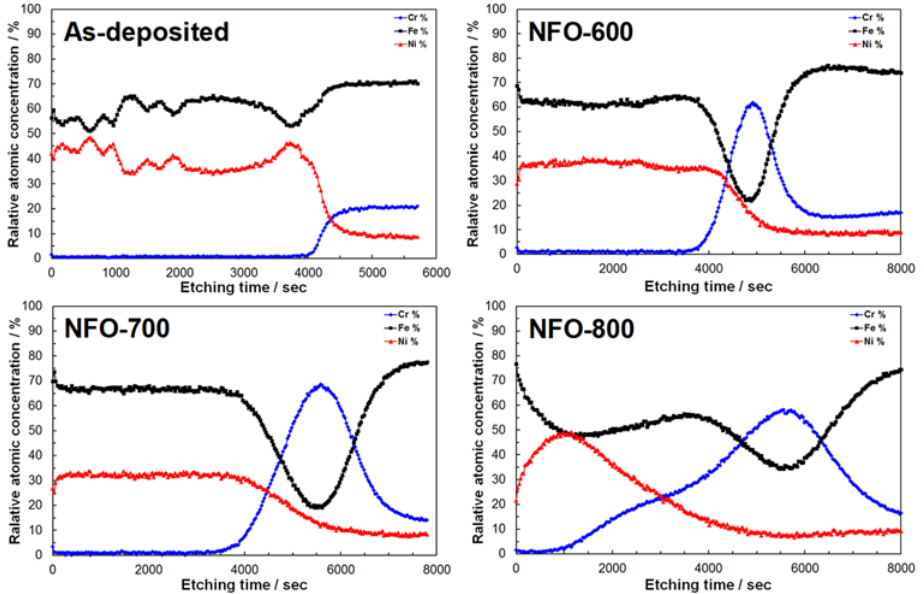
Figure 6. The “in depth” relative atomic concentrations of the NiFe 2 O 4 electrode annealed at different temperatures from XPS-depth profiles.